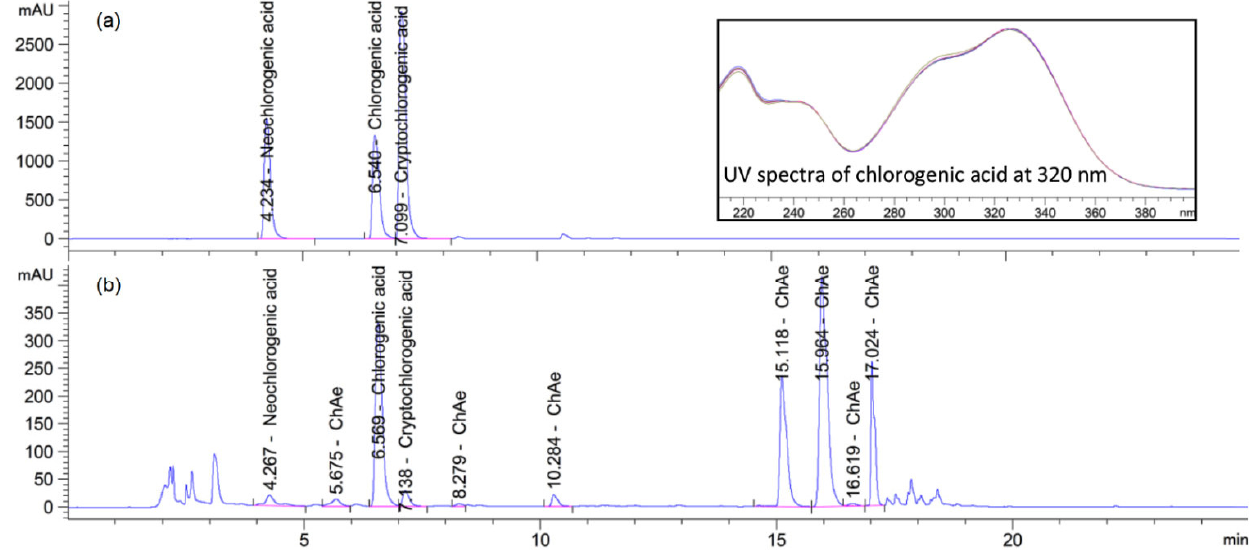
Figure 1. HPLC chromatogram of chlorogenic acids standards at 320 nm with UV spectrum ( a ) and chromatogram of the sweet potato sample of Beauregard variety after baking ( b ) .